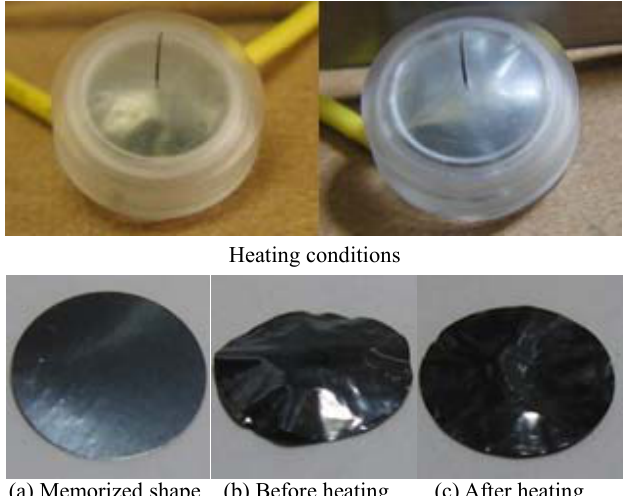
Figure 10. Recovery action of SMA foil transducer without a